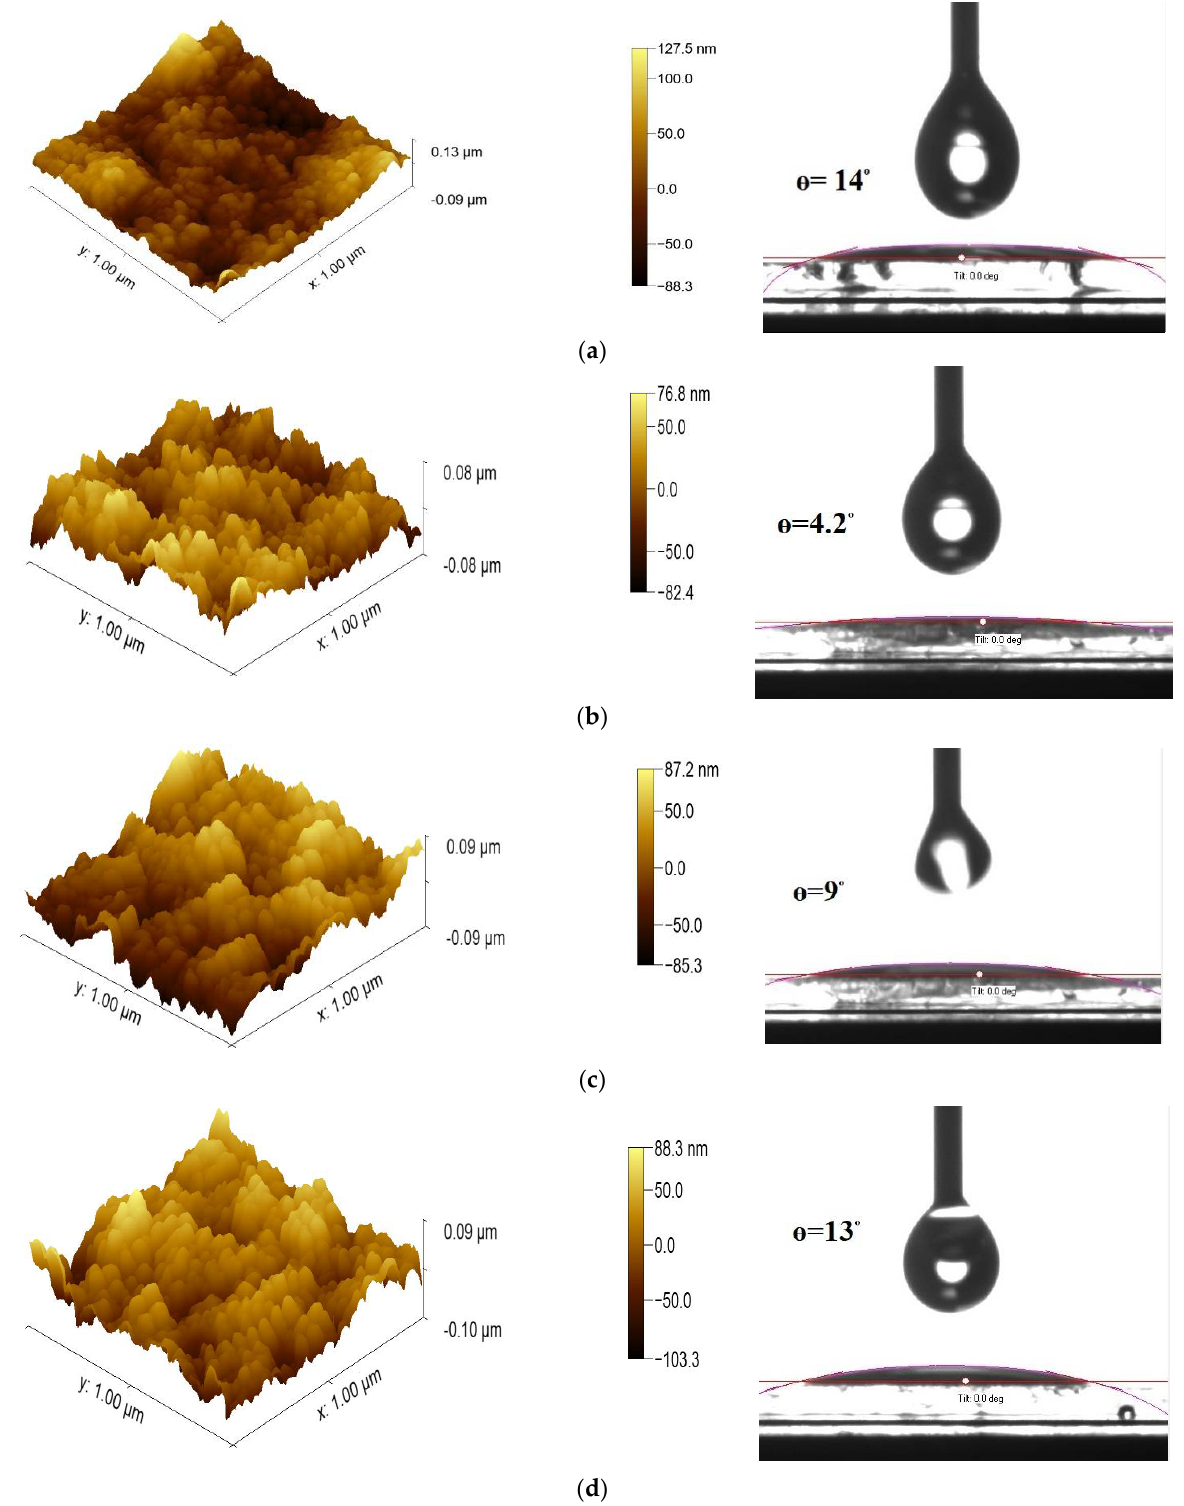
Figure 1. Left, AFM images of the surface morphology structure and roughness of the ( a ) undoped mesoporous TiO 2 , RMS = 34.5 nm; ( b ) M-TiO 2 doped with FK209, RMS = 16 nm; ( c ) FK209/Li + , RMS = 22.75 nm; ( d ) Li + , RMS = 25.46 nm. Right, contact angle measurement of ( a ) undoped M-TiO 2 , ɵ = 14°; ( b ) M-TiO 2 doped with FK209, ɵ = 4.2°; ( c ) FK209/Li + , ɵ = 9°; ( d ) Li + , ɵ = 13°.